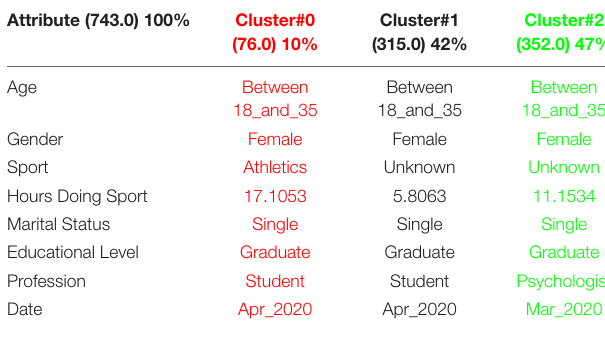
TABLE 9 | 3 clusters IPED analysis for March to May 2019. TABLE 10 | 3 clusters IPED analysis for March to May